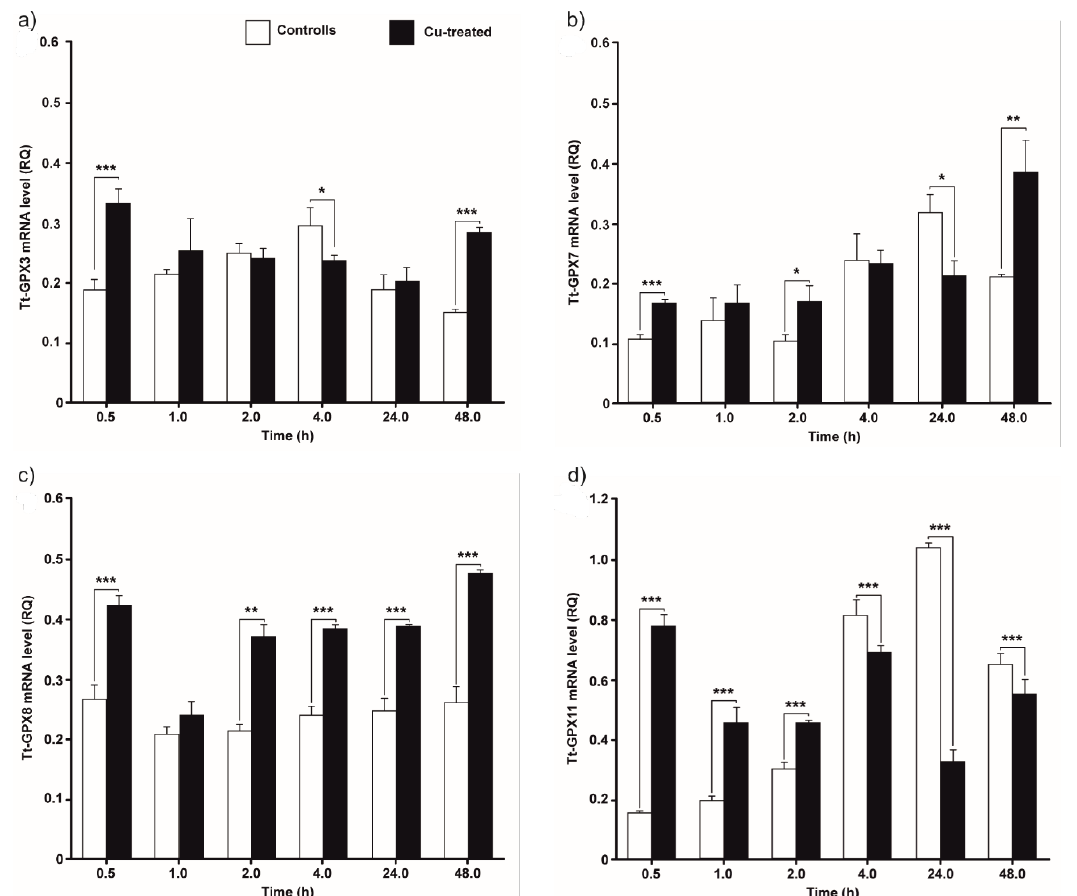
Figure 4. Expression levels of Tt-gpx3 ( a ), Tt-gpx7 ( b ), Tt-gpx8 ( c ) and Tt-gpx11 ( d ) GPx mRNAs in control and copper- (Cu)-treatment conditions. T. thermophila cells harvested at 0.5, 1, 2, 4, 24, and 48 h. The results are reported as mean of three independent experiments ± SD. Statistical differences between the two experimental groups are reported as follows: (*) p < 0.05, (**) p < 0.005 and (***) p < 0.001.